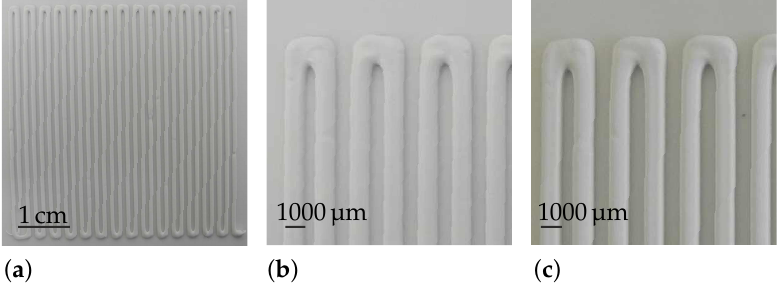
Figure 3. Photographs of a robocasted sample being produced with a nozzle with an 840µm diameter. ( a ) shows the complete layer after printing; ( b ) shows a zoom into the filament; ( c ) shows the same position as in ( b ), but after drying for